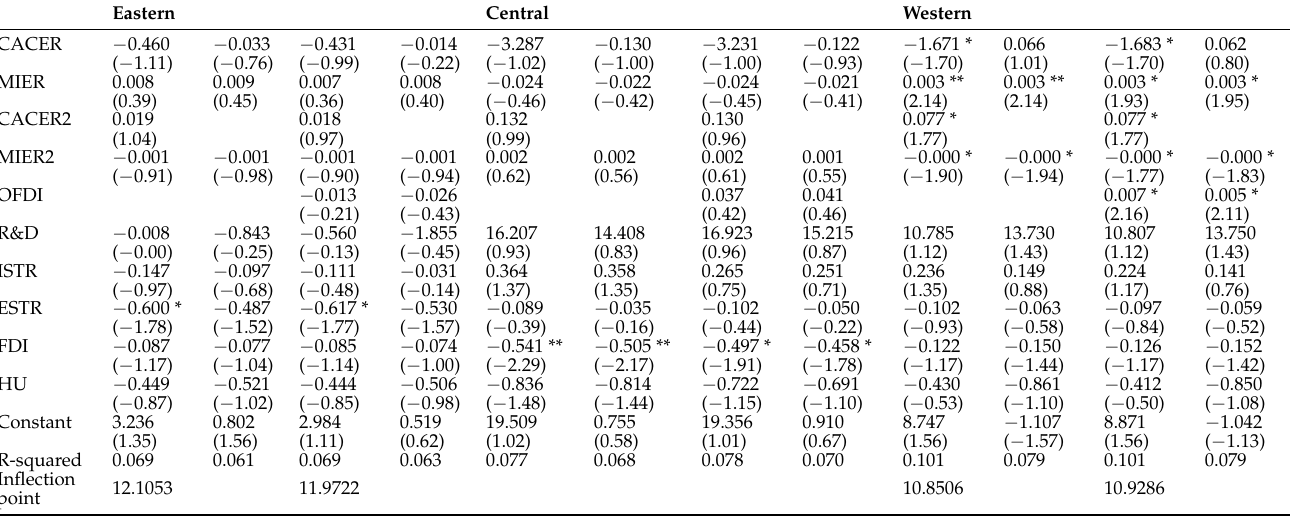
Table A5. Estimated results of the impact of ERs and OFDI on GTFP across regions (POOL regression). Eastern Central Western